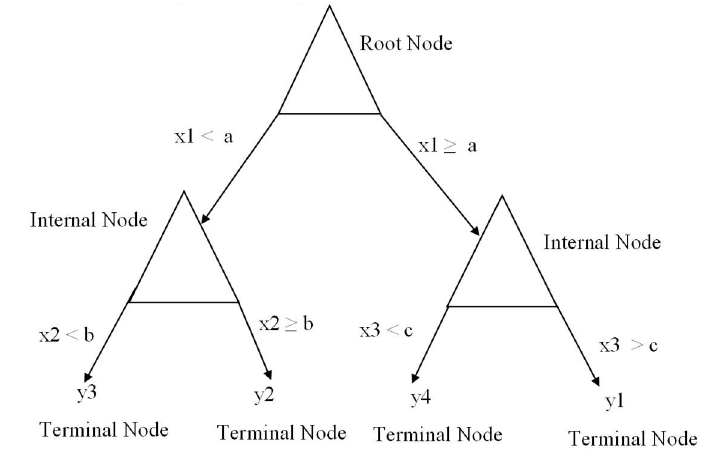
Figure 1. An example of a decision tree .